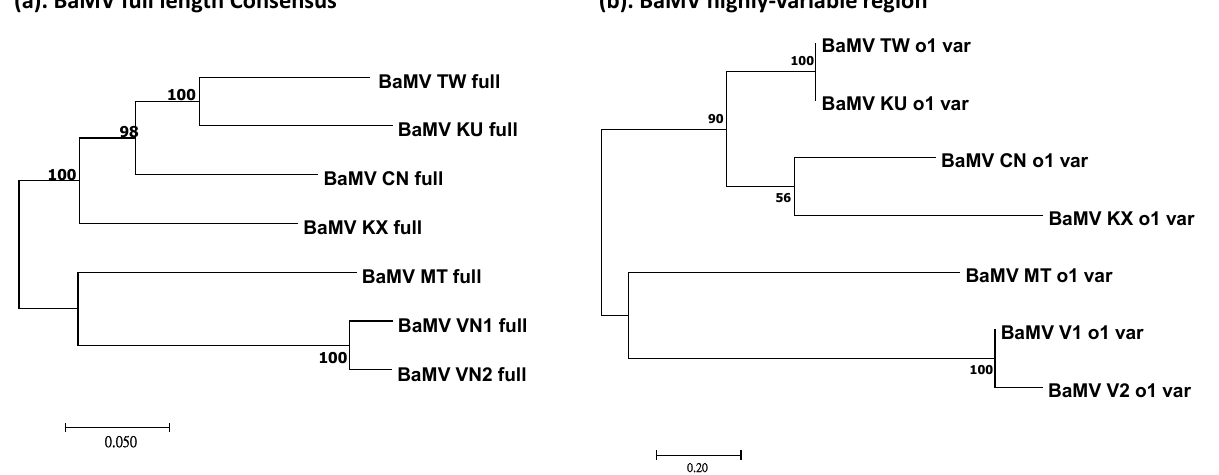
Figure 7. Molecular phylogenetic analysis of BaMV using consensus full-length sequences or the highly variable regions of the ORF1 coding sequence by Maximum Likelihood method. The phylo- genetic relationship of BaMV strains was inferred from the full-length sequences ( a ) or the highly variable regions of ORF1 ( b ). For clarity, consensus sequences of BaMV strains/isolates were gener- ated based on the clustering of the full-length BaMV genomes. These consensus sequences were then aligned using CLUSTAL W [31] and subjected to infer phylogenetic relationship using the Maximum Likelihood method based on the Tamura-Nei model [39]. The horizontal branch lengths are drawn to scale, relative to the scale bar at the bottom, representing the number of substitutions per site. Evolutionary analyses were conducted in MEGA X [30]. The suffixes “full” or “o1 var” to the name of the sequence indicate the phylogenetic relationship reconstructed using the full-length or the highly variable region of ORF1 coding sequences, respectively.